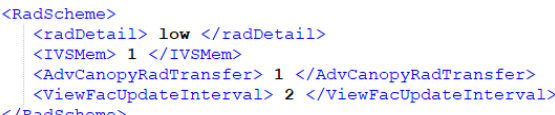
Figure 3. User-defined update interval for the view and transmission factor analysis in the SIMX-File—value is given as integer in days, here two.